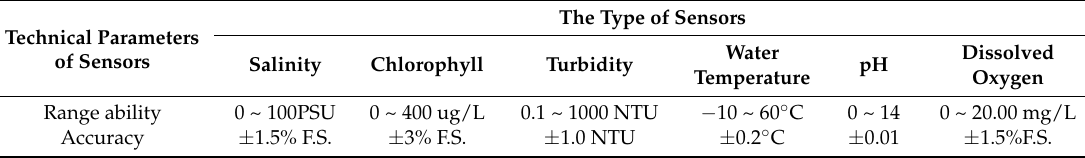
Table 3. The accuracy and range ability of the sensors.